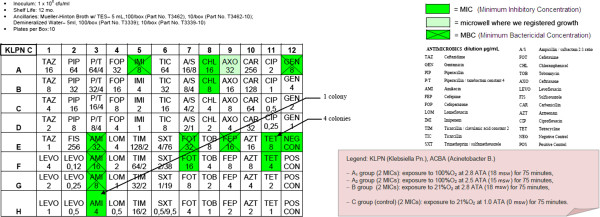
KLPN plate exposed to 21% O2at 1.0 ATA.